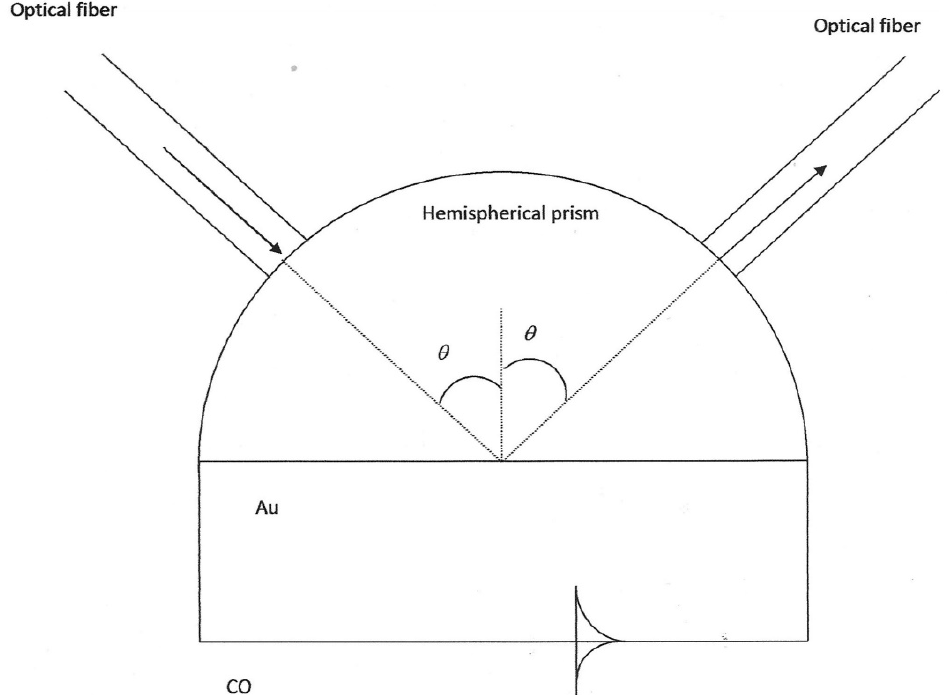
Figure 1. Diagram of the plasmonic sensor. An optical fiber transports the incident radiation on the left part of the hemispherical prism, and another optical fiber collects the reflected radiation on the right. The surface plasmon polaritons are shown propagating along the Au-CO interface.